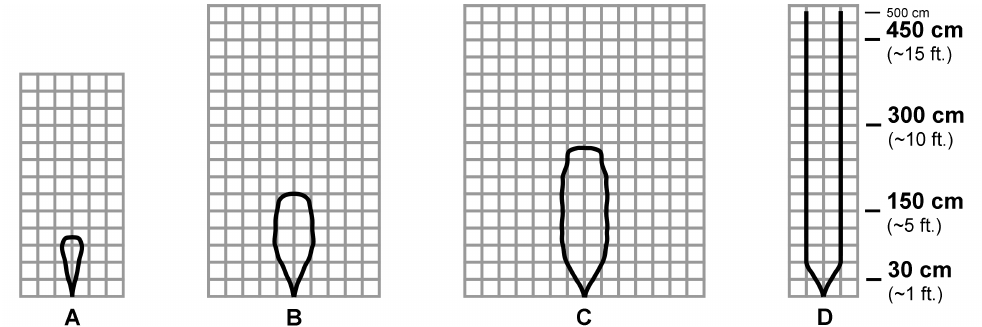
Figure 3. Two-dimensional beam pattern representation of the MaxBotix MB1433 ultrasonic